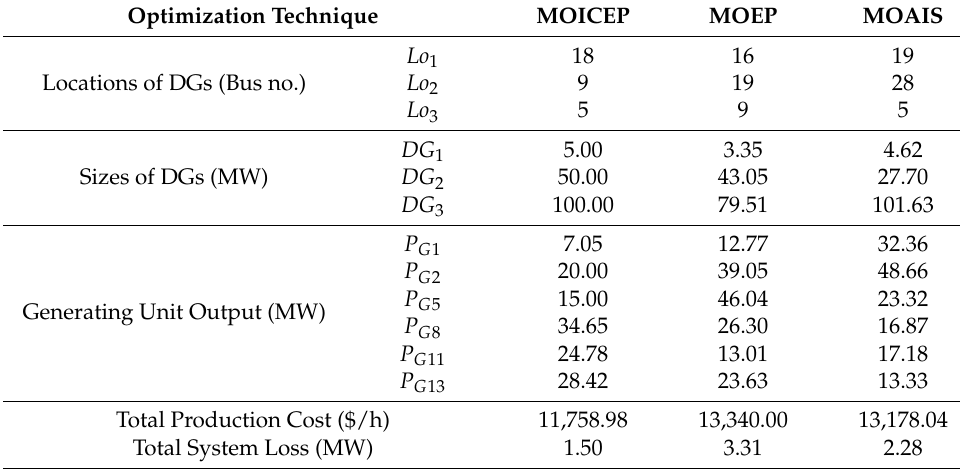
Table 18. Results of the integrated ED problem with a valve-point loading effect and DG installation of the IEEE 30-Bus RTS ( w 1 = 0.5 and w 2 = 0.5). Optimization Technique MOICEP MOEP MOAIS Locations of DGs (Bus no.)